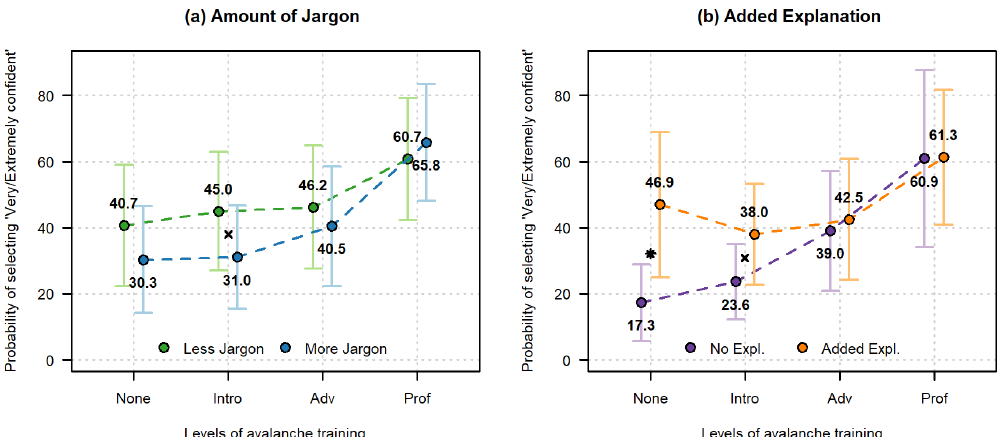
Figure 7. Estimated marginal probabilities for selecting very confident or extremely confident for recognizing condition in the field as a function of (a) the interaction effect of avalanche training and amount of jargon and (b) the interaction effect of avalanche training and added explanation. Error bars represent 95% confidence intervals for probabilities calculated from the subsample for the particular parameter level. Significant post hoc pairwise comparisons are indicated with asterisks ( p values < 0.01), diagonal crosses (0.01 ≤ p values < 0.05),